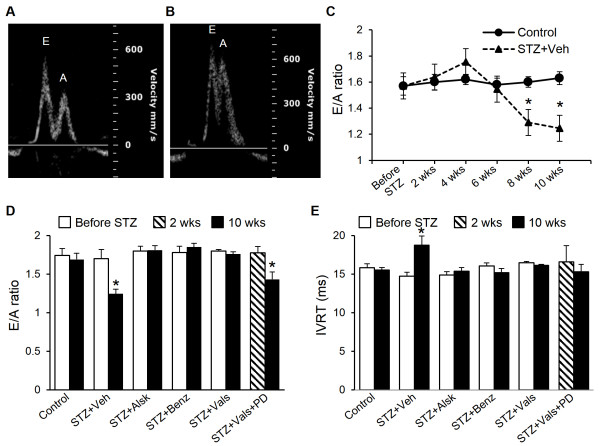
Measurement of diastolic function by echocardiography. Representative pulsed-wave Doppler images of Mitral valve flow of Control and STZ + Veh mice at 10 wks of diabetes (A and B, respectively). Temporal recordings of Mitral valve flow velocity (E/A) in control and diabetic mice implanted with saline minipumps (STZ + Veh), demonstrating development of diastolic dysfunction (C). Mitral valve flow velocity (D) and isovolumic relaxation time (E) of Control, STZ + Veh, and those treated with aliskiren (STZ + Alsk), benazeprilat (STZ + Benz), valsartan (STZ + Vals), and valsartan + PD123319 (STZ + Vals + PD); before STZ treatment and at 10 wks after becoming diabetic. 2 wk values for STZ + Vals + PD are shown, as we could not collect reliable (before STZ) data in this group. Values are expressed as the mean ± SEM. *P < 0.05 vs. Control (C) or respective Before STZ (D and E).